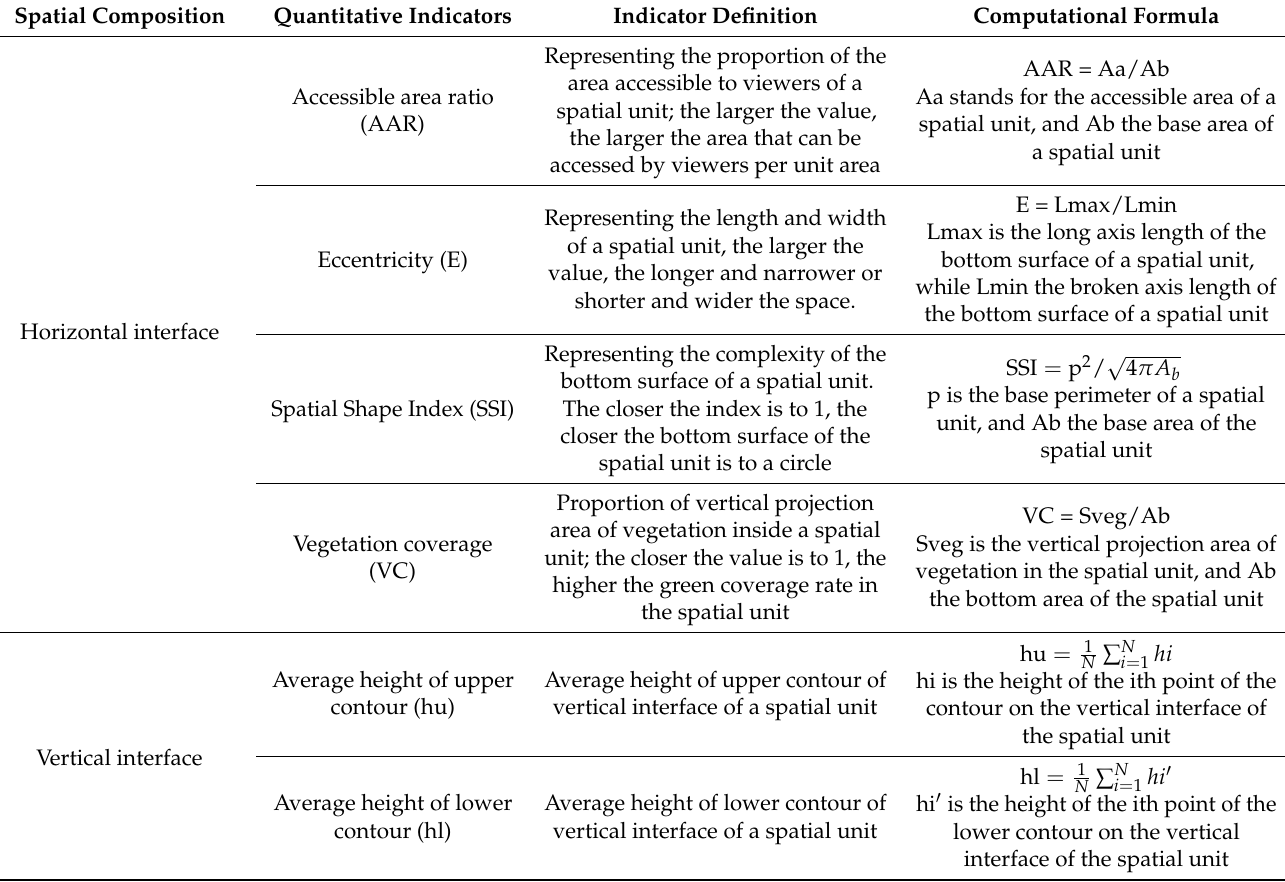
Table 1. Quantitative index system of traditional village public space